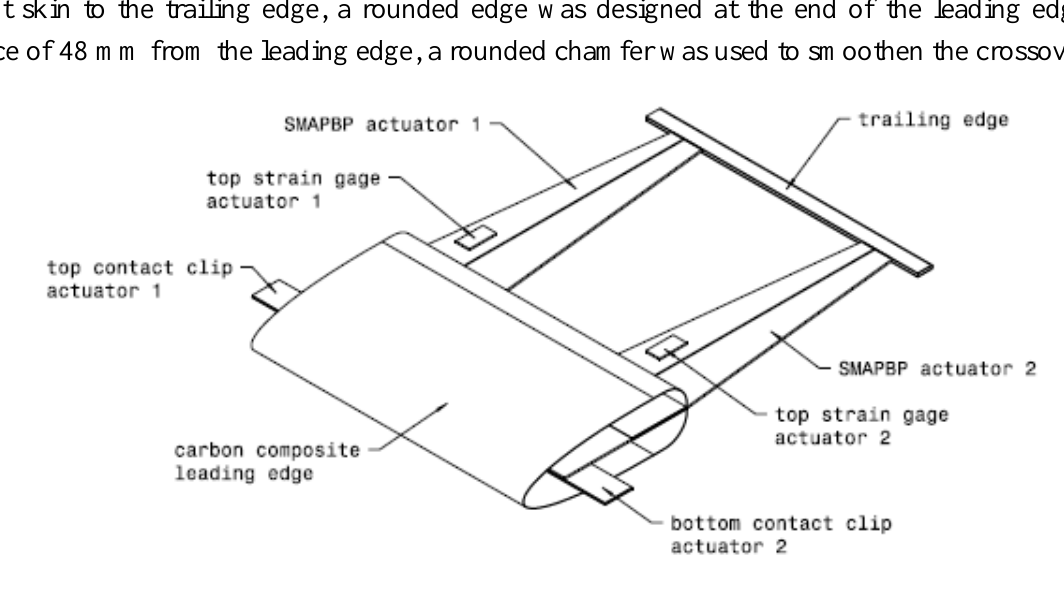
Figure 4. Drawing of assembled airfoil without applied